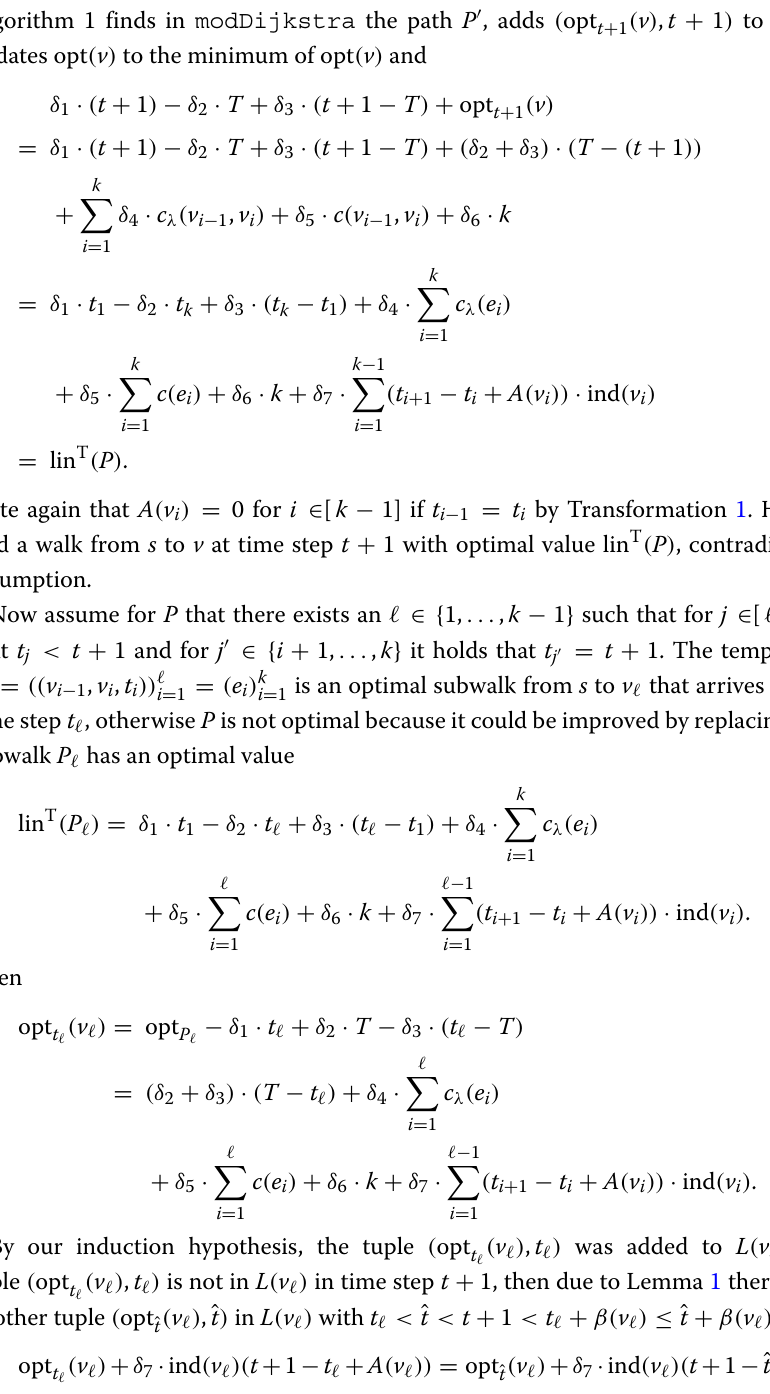
( v ) , t + 1 ) to L ( v ) , and t + 1